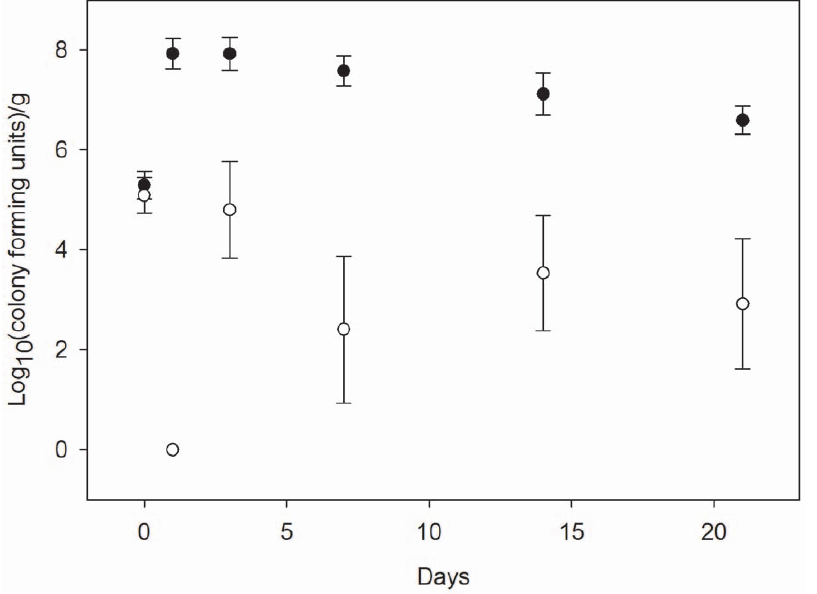
Figure 4. Ceftiofur metabolites confer selective advantage to cef R E.coli by restricting cef S population in soil. Mean colony forming units for presumptively ceftiofur sensitive (cef S ) fecal E. coli in a matrix of sandy soil and feces (25:1) after addition of urine containing 0 ppm (open circles) or 50 ppm (closed circles) CFM and incubated at 23 u C. Bars=s.e.m.